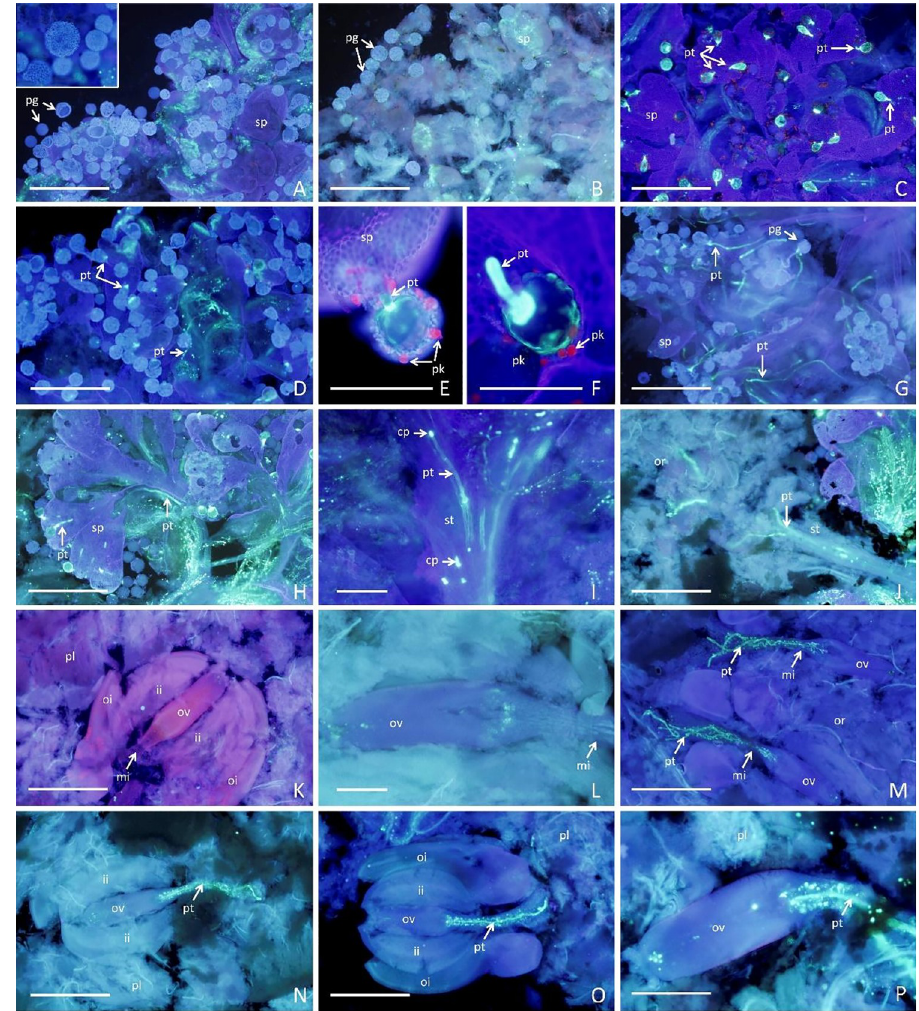
Fig 4. Overview of cassava pistils stained with aniline blue and visualized by fluorescence microscopy 48 hours after pollination. (A) Absence of germination and polymorphism in pollen grains from the BGM-0661 × BRS Jari cross; B) few pollen grains germinated on the surface of the stigmatic papillae with penetration of the pollen tube in the BGM-0661 × BGM-2167 cross; (C–D) pollen grains germinated on the surface of the stigmatic papillae with penetration of the pollen tube in the Aipim Abacate x BRS Novo Horizonte and BGM-0470 × BRS Novo Horizonte crosses, respectively; (E–F) presence of pollenkitt in the germinated pollen grains; (G) pollen tube growth ceased at the first third of the stylus in the 7909–04 × BGM-0661 cross; (H–I) pollen tubes within the stylet, showing the irregular deposition of callose plates; J) pollen tubes in the ovary with growth toward the ovary; (K–L) unfertilized ovule; (M–P) ovule being fertilized in compatible crosses (BGM-0728 × Aipim Abacate, BRS Novo Horizonte × Aipim Abacate, BGM1760 × BGM-2338, and BGM-2338 × BGM-0019, respectively). Bars: A–D, G–H, J–K, and M–P = 1 mm; E, F, I, and L = 200 μ